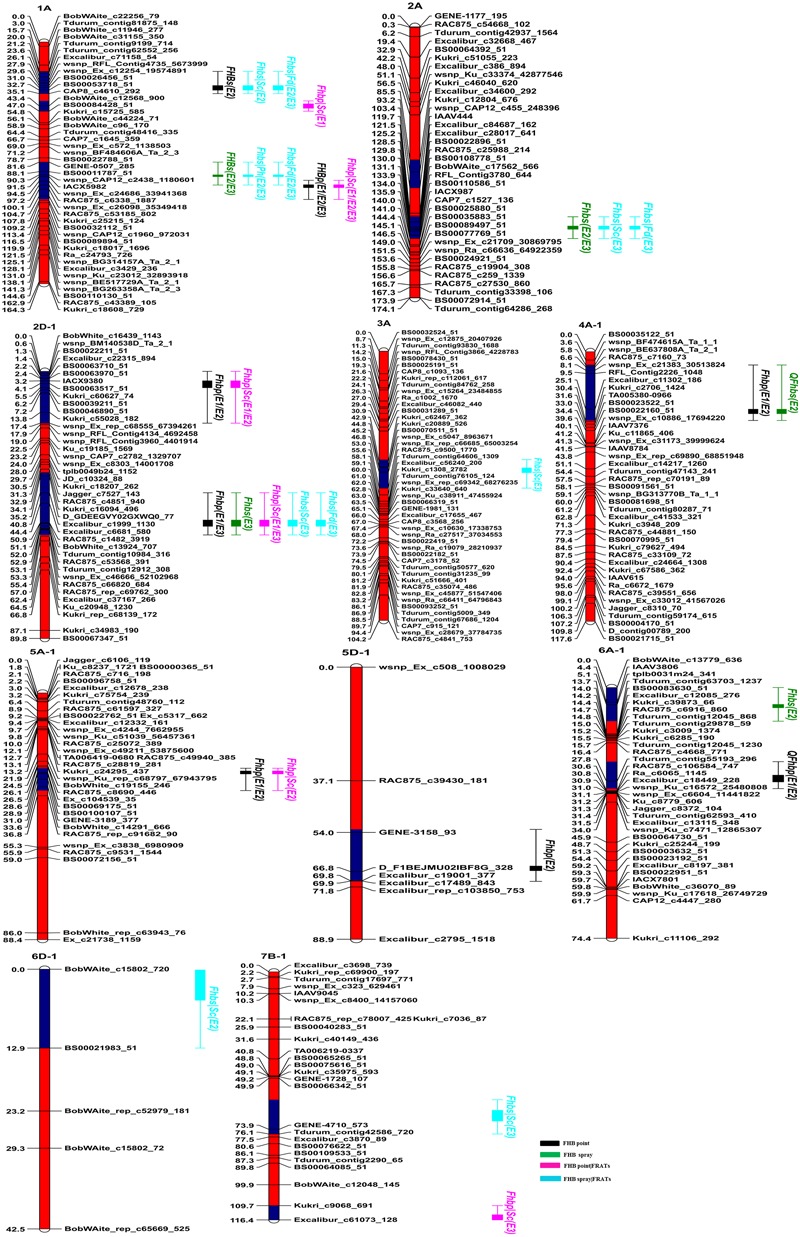
Genetic linkage maps and locations of QTL for FHB resistance in the C615/Yangmai 13 population. Red and blue regions on chromosomes indicate confidence intervals of QTL. QTL names are on the right with different colors for different traits. FHB point, FHB evaluated after point inoculation; FHB spray, FHB evaluated after spray inoculation; FHB point|FRATs, FHB point without the influence of related agronomic traits (e.g., PH, SC, and FD); FHB spray|FRATs, FHB spray without the influence of three related agronomic traits.